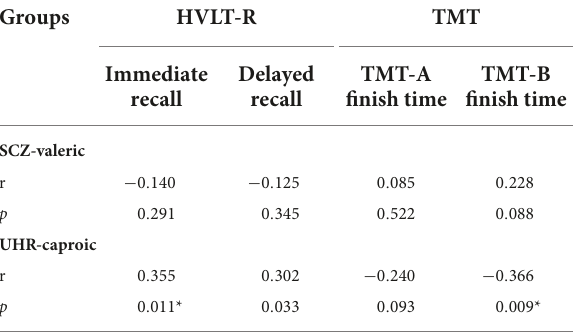
TABLE 5 Correlation analysis of short-chain fatty acids (SCFAs) with cognitive function. Groups HVLT-R TMT Immediate Delayed TMT-A TMT-B recall recall finish time finish